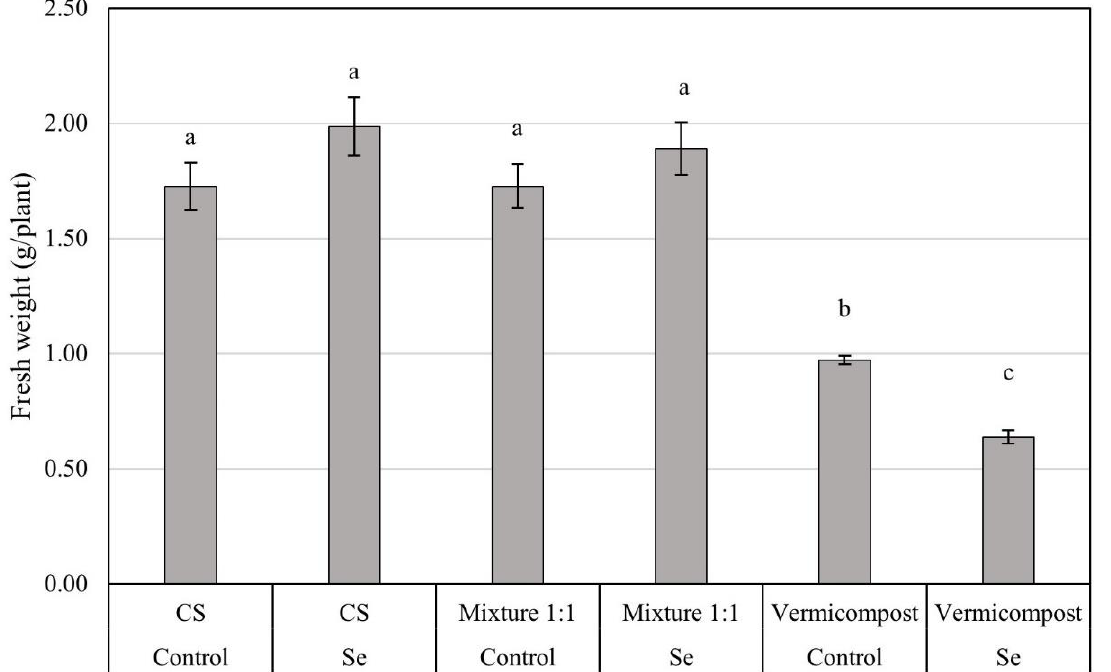
Figure 1. Mean values ± standard error of the fresh weight (FW) per plant (g) over the main-effects Se treatment and growing media commercial substrate (CS), vermicompost and mixture 1:1. The different letters represent the significance of the differences at the α = 0.05 level.